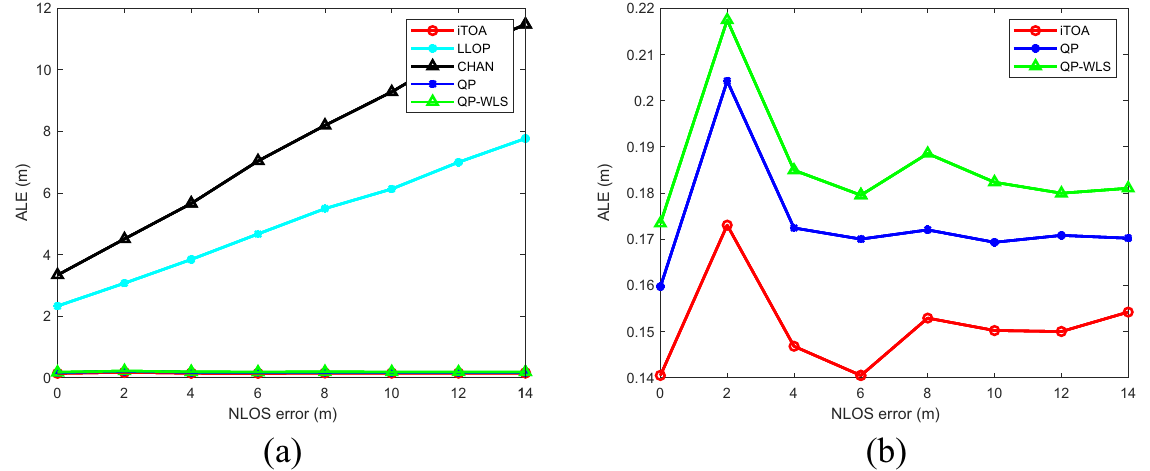
Figure 3: ALE of di ff erent time synchronization errors of fi ve algorithms when the NLOS error value is fi xed at 3m. ( a ) ALE diagram of fi ve algorithms and ( b ) ALE diagram of three